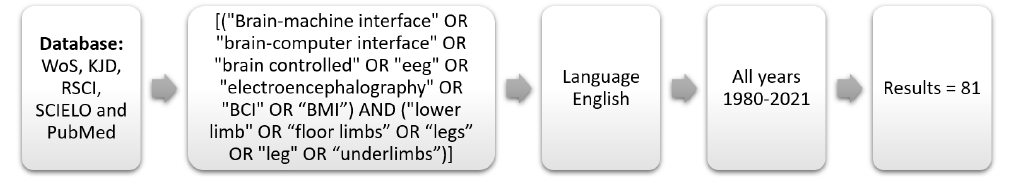
Figure 3. Search Results on WoS, KJD, RSCI, SCIELO, and PubMed.